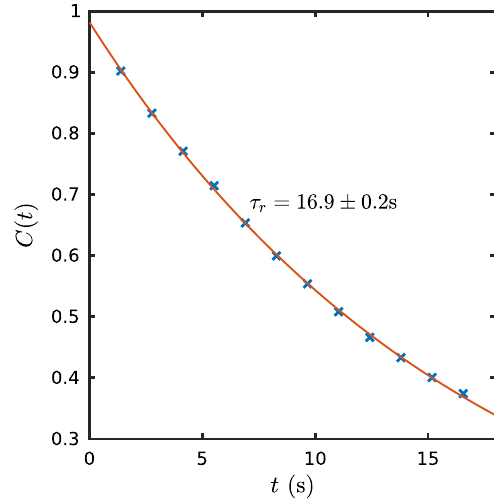
FIG. 5. Orientation autocorrelation C ð t Þ for core-shell OCULI in the ultradilute limit. Here, C ð t Þ is for the same core-shell OCULI particles used for the dense crystalline sediment. The data fit well with an exponential decay (red solid